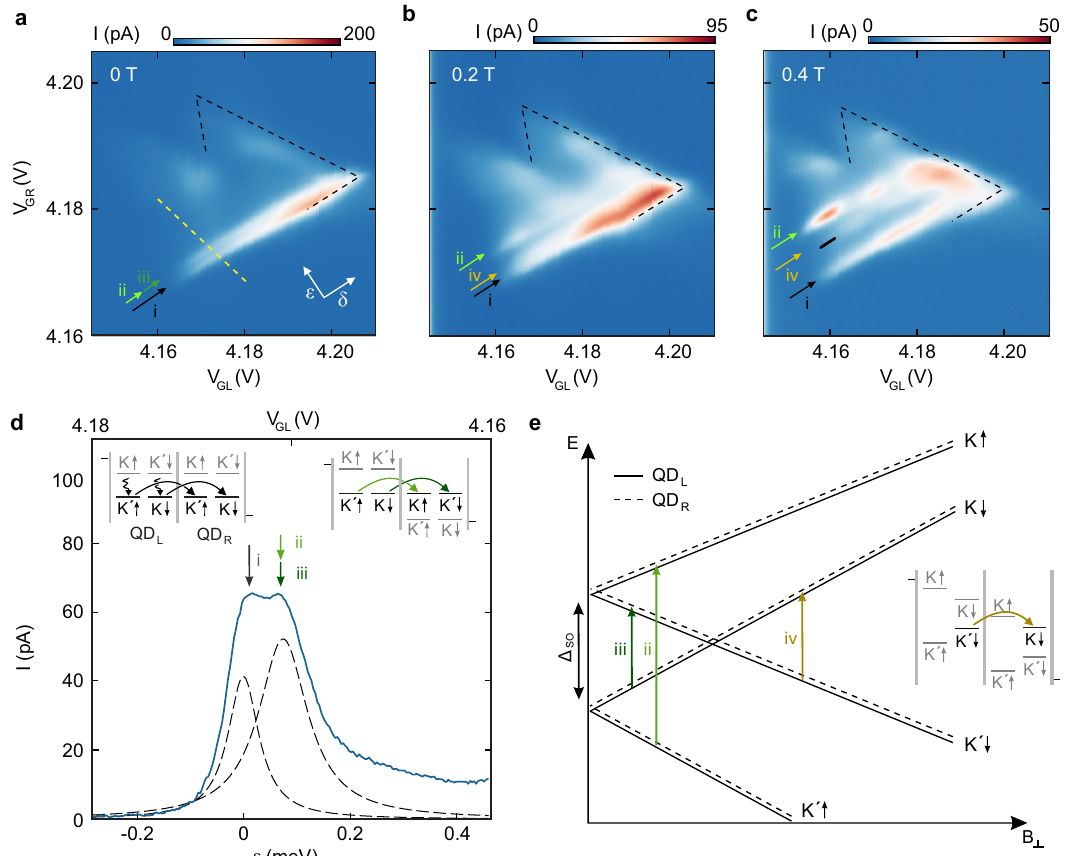
Fig. 3 (0,1)-(1,0) triple point. Charge stability diagrams of the fi rst pair of triple points ((1,0)-(0,1) transition) measured at V b = 1mV and a B ⊥ = 0 T, b B ⊥ = 0.2 T, c B ⊥ = 0.4 T. The white arrows in panel a indicate the orthogonal detuning axis ε and the DQD ’ s common energy δ . At zero magnetic fi eld, two transition lines are visible (green and black arrows). d Cut along the yellow dashed line in the fi rst triple point at B = 0 T. Two Lorentzian peaks are fi t to the data to extract a splitting of Δ SO = 68 ± 7 μ eV. Inset: Schematic energy diagrams of a DQD in the fi nite bias regime for different interdot detuning energies ε , illustrating resonant transport through the ground state of each QD (transition (i); left inset) and resonant transport at ε = Δ SO (transitions (ii) and (iii); right inset). e Schematic of the single particle energy spectra of the fi rst orbital of each QD as a function of B ⊥ . The arrows (color coding as in panels a – c ) indicate spin conserving transitions from single particle states in the left QD (solid lines) to single particle states in the right QD (dashed lines). The inset shows the transition (iv) at fi nite magnetic fi eld.